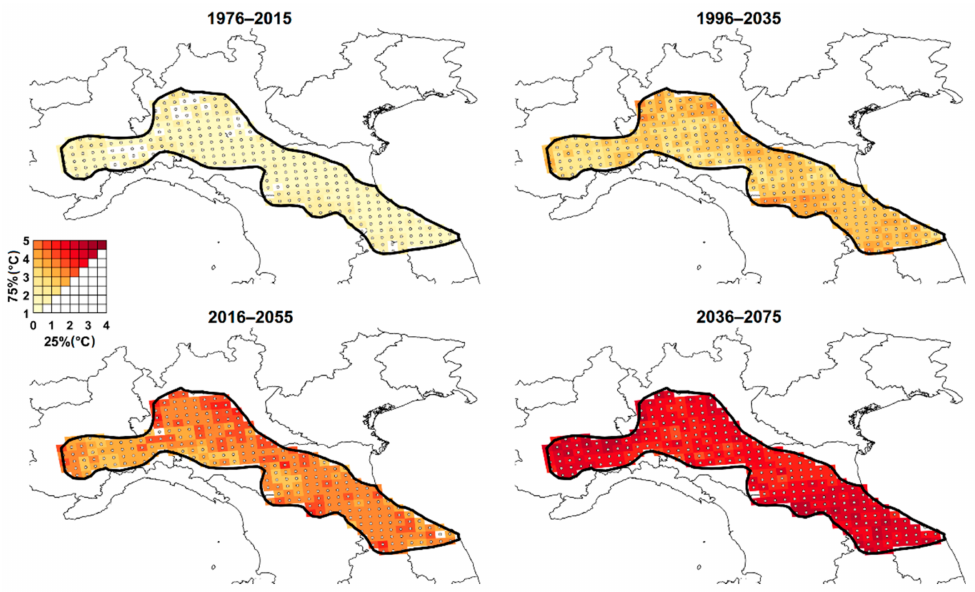
Figure 7. Factors of change for T Max,k in the time windows 1976–2015, 1996–2035, 2016–2055, and 2036–2075 in comparison with the reference time interval 1956–1995—prediction interval (25–75%) map (Scenario RCP8.5). Table 3 summarizes the average factors of change obtained in the investigated region according to the RCP4.5 and RCP8.5 emission scenarios. In the table, results corresponding to prediction percentiles 25%, 50%, and 75% are given for each time window considered in the study. Table 3. Mean of factors of change ( ◦ C) percentiles for T Max,k in the study region. Time Window